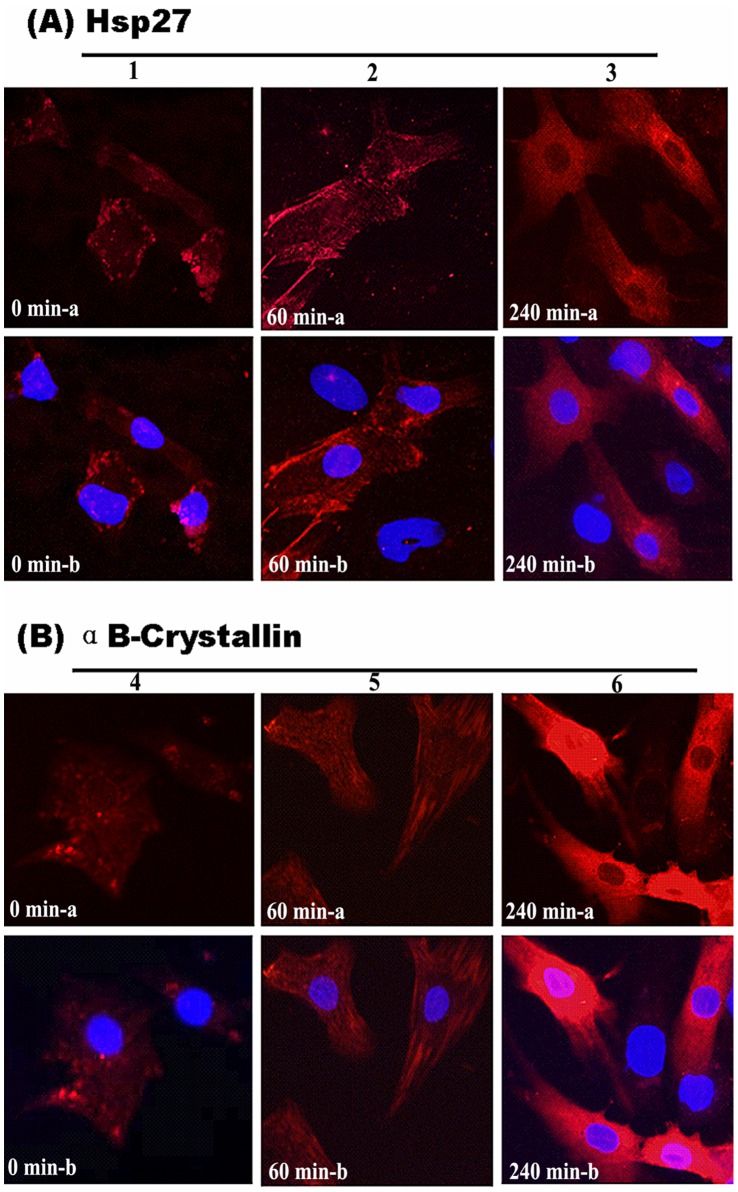
Distribution of Hsp27 and αB-crystallin in control and heat-stressed myocardial cells.A: Hsp27, a: Hsp27 (Rhodamine); b: merge. B: αB-Crystallin, a: αB-Crystallin (Rhodamine ); b: merged. 1: Smeared and granular Hsp27 signals can be seen distributed in the cytoplasm and nucleus of the control myocardial cells; 2: Stronger positive signals for Hsp27 were observed in both the nucleus and cytoplasm at 60 min of heat stress compared with the control group; 3: Hsp27 was distributed mainly in the cytoplasm after 240 min of heat stress, but weak signals were observed in the nucleus. 4: αB-Crystallin was found distributed in the form of smashed granules in the cytoplasm of the control myocardial cells. 5: Stronger αB-crystallin signals were found scattered in the cytoplasm of myocardial cells exposed to heat stress compared with the control group after 60 min of heat stress. 6: After 240 min of heat stress, the strongest positive signals for αB-crystallin were observed in both the cytoplasm and nucleus of myocardial cells.